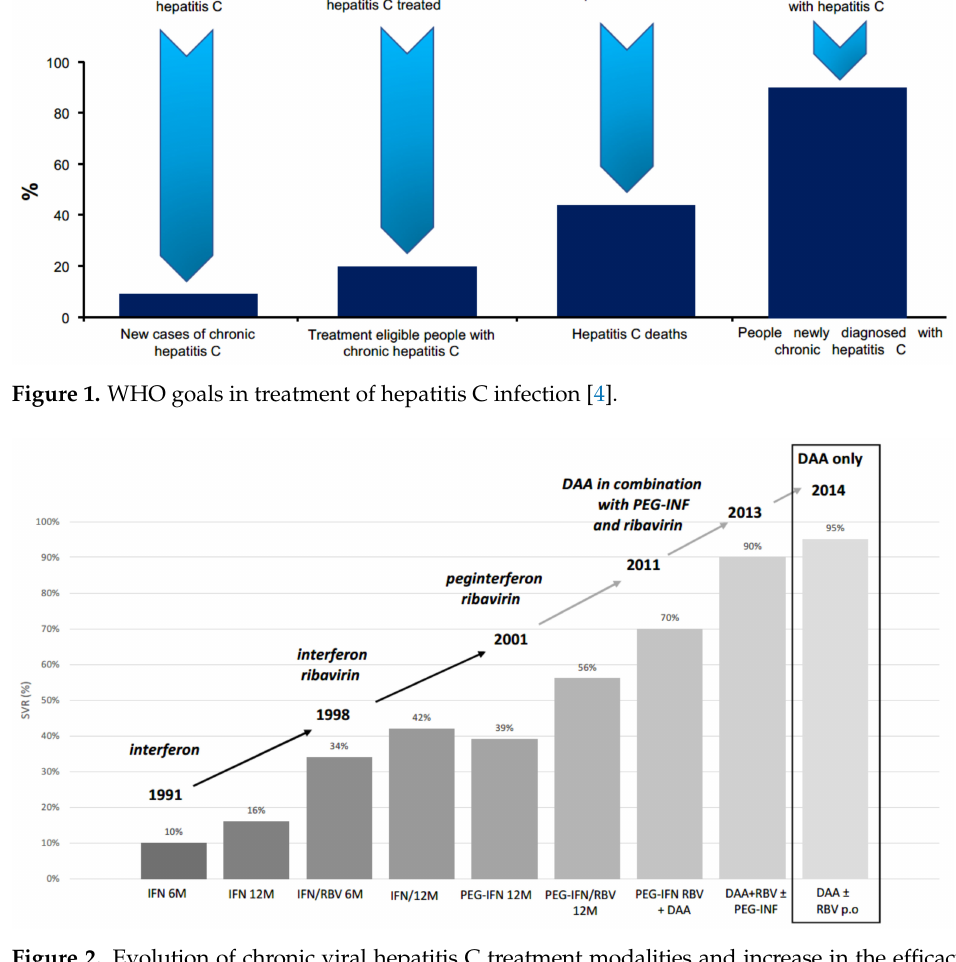
Figure 2. Evolution of chronic viral hepatitis C treatment modalities and increase in the efficacy of viral clearance measured as sustained virologic response [16]. SVR, sustained virological response; IFN, interferon; RBV, ribavirin; PEG-IFN, peginterferon (pegylated interferon); DAA, direct-acting antivirals.